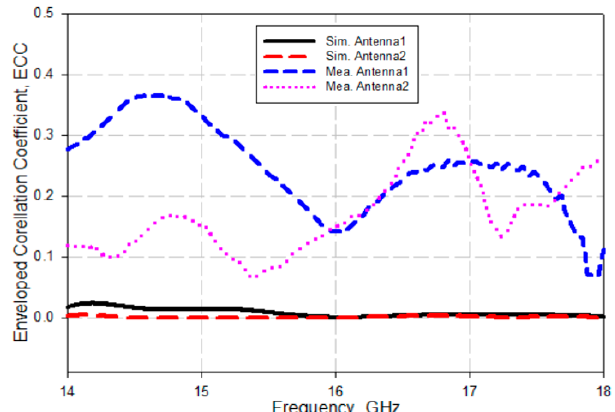
Figure 13. Measurement of total average reflection coefficient (TARC).